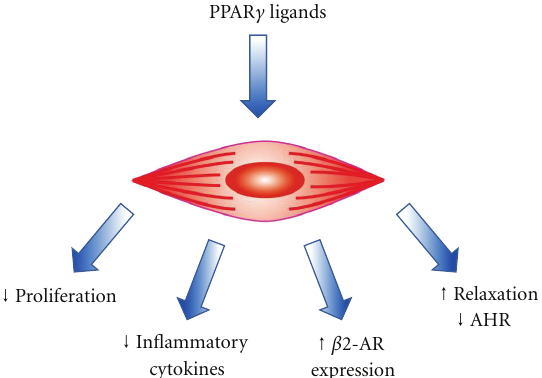
Figure 2: PPAR γ ligands regulate noncontractile and contractile functions of airway smooth